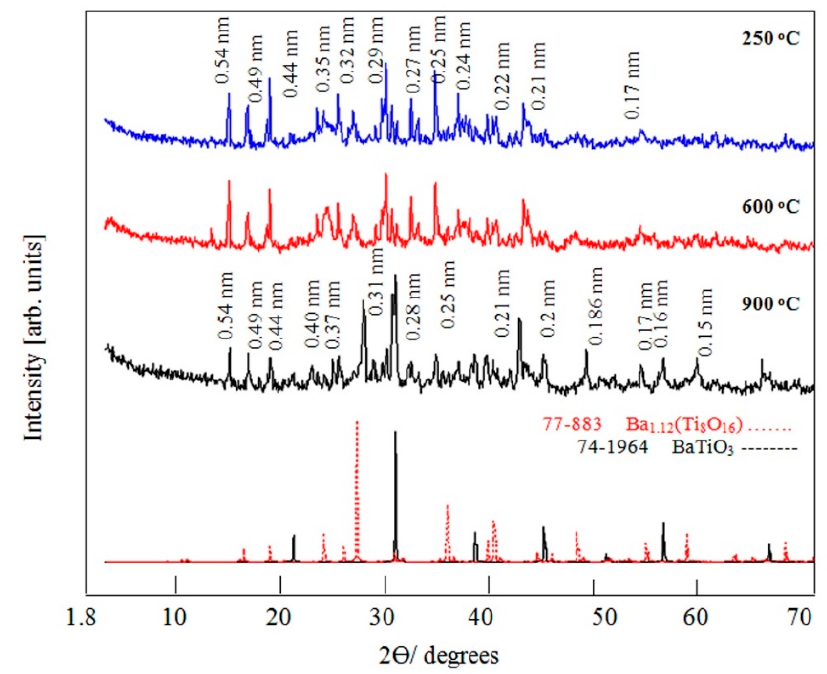
Figure 2. XRD patterns of BT2 at different temperatures.